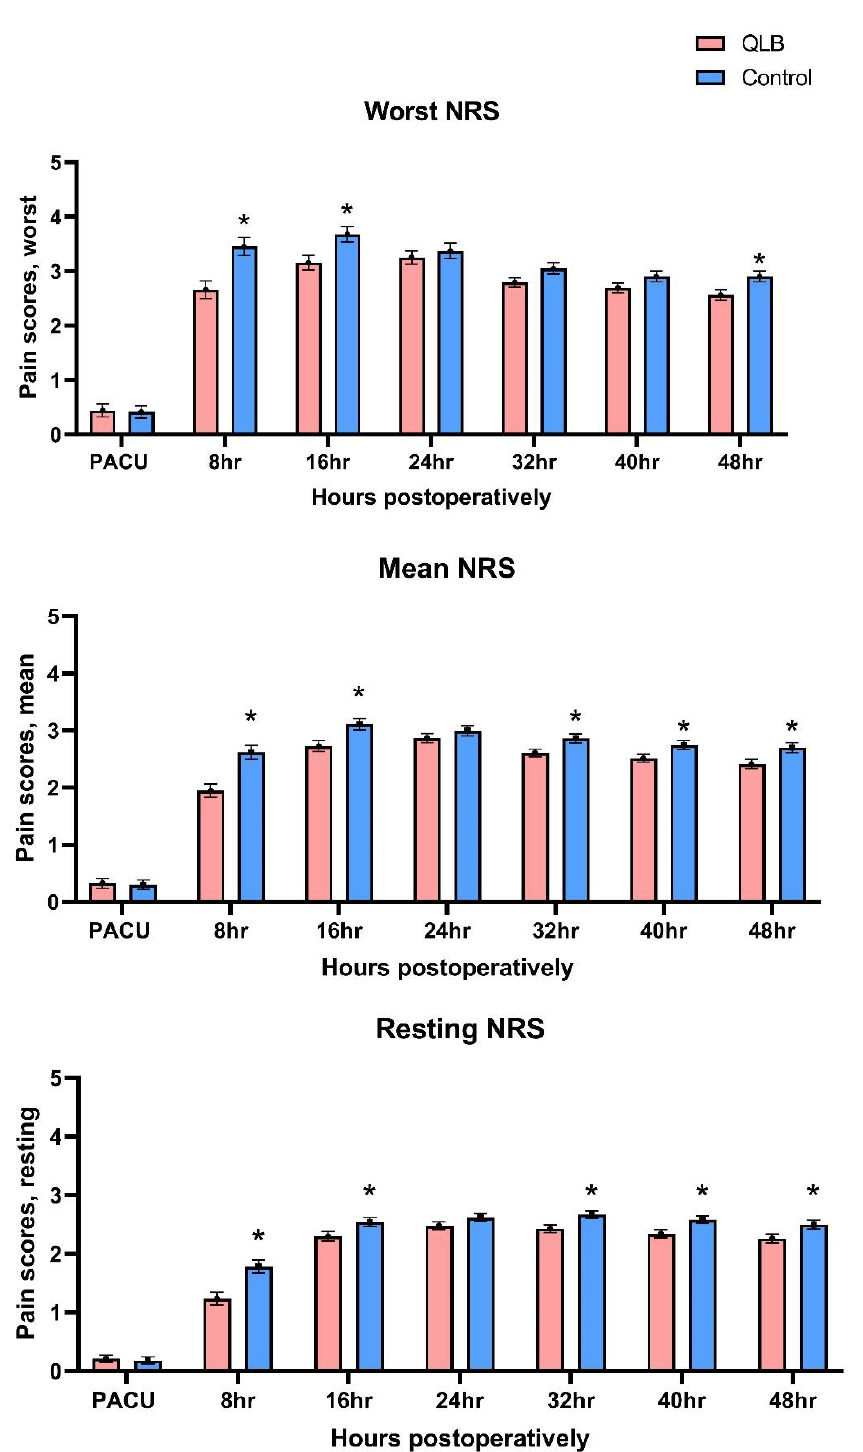
Figure 4. Comparison of pain intensity in the PACU at 8, 16, 24, 32, 40, and 48 h after surgery between QLB and Control groups. Values are mean ± SD. * p < 0.05 PACU, post-anesthesia care unit; NRS, numeral rating scale; QLB, quadratus lumborum block.